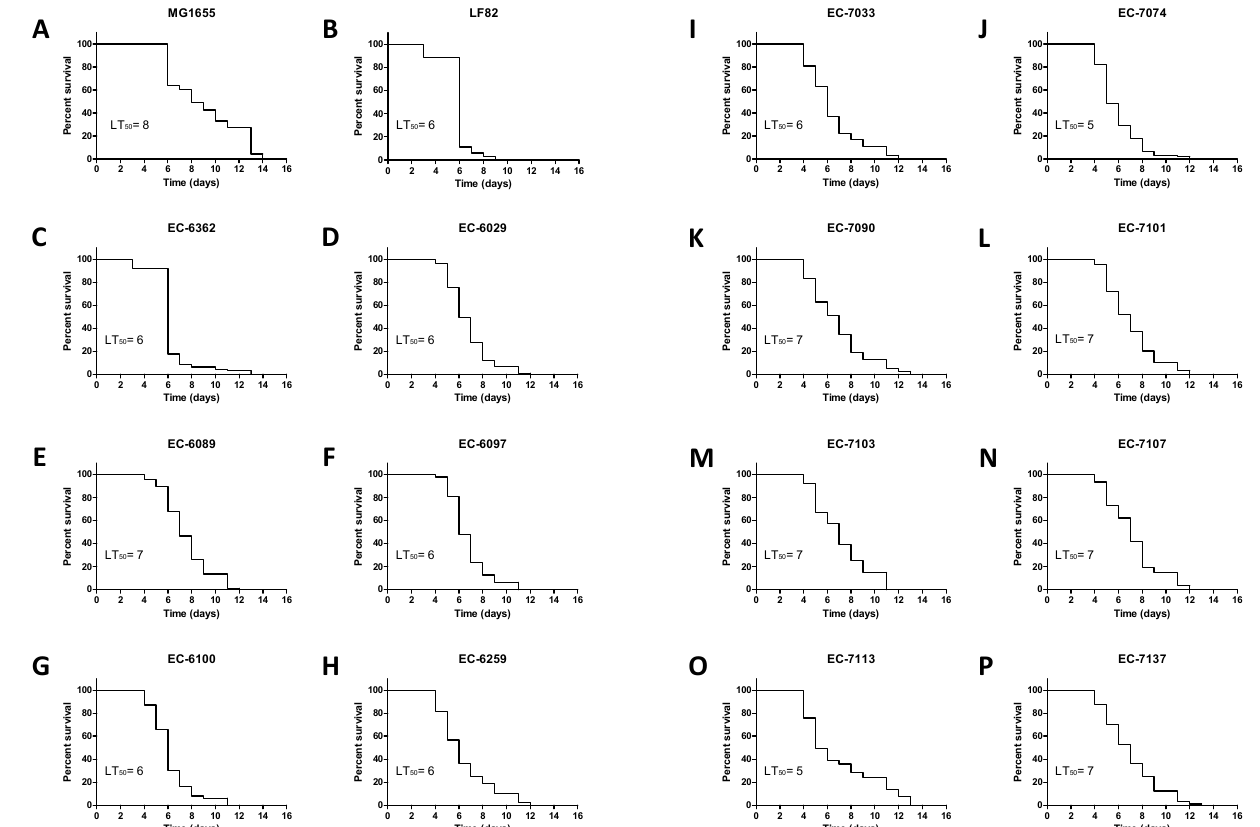
Figure 7. Kaplan–Meier survival plots from individual killing assays for C. elegans (PX627) infected with 16 distinct E. coli strains. The “ n ” values in brackets correspond to the initial number of larvae investigated for each bacterial strain. C. elegans young adults were transferred to lawns of ( A ) MG1655 ( n = 94), ( B ) LF82 ( n = 98), ( C ) EC-6362 ( n = 96), ( D ) EC-6029 ( n = 101), ( E ) EC-6089 ( n = 88), ( F ) EC-6097 ( n = 94), ( G ) EC-6100 ( n = 100), ( H ) EC-6259 ( n = 97), ( I ) EC-7033 ( n = 94), ( J ) EC-7074 ( n = 89), ( K ) EC-7090 ( n = 78), ( L ) EC-7101 ( n = 89), ( M ) EC-7103 ( n = 94), ( N ) EC-7107 ( n = 93), ( O ) EC-7113 ( n = 99), and ( P ) EC-7137 ( n = 97). The median lifespan (LT 50 ) for each evaluated strain is expressed in